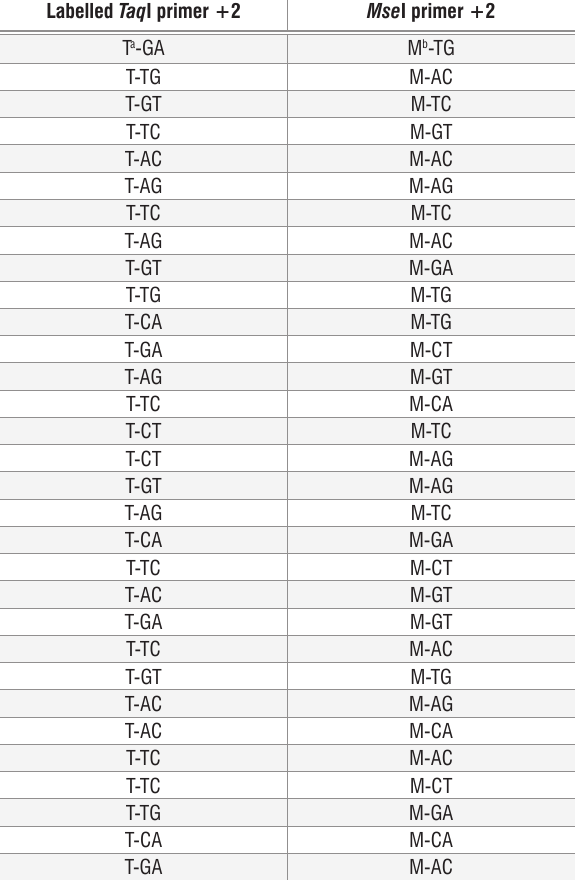
Primers used for the selective amplification of cDNA- amplified fragment length polymorphism fragments in Fusarium